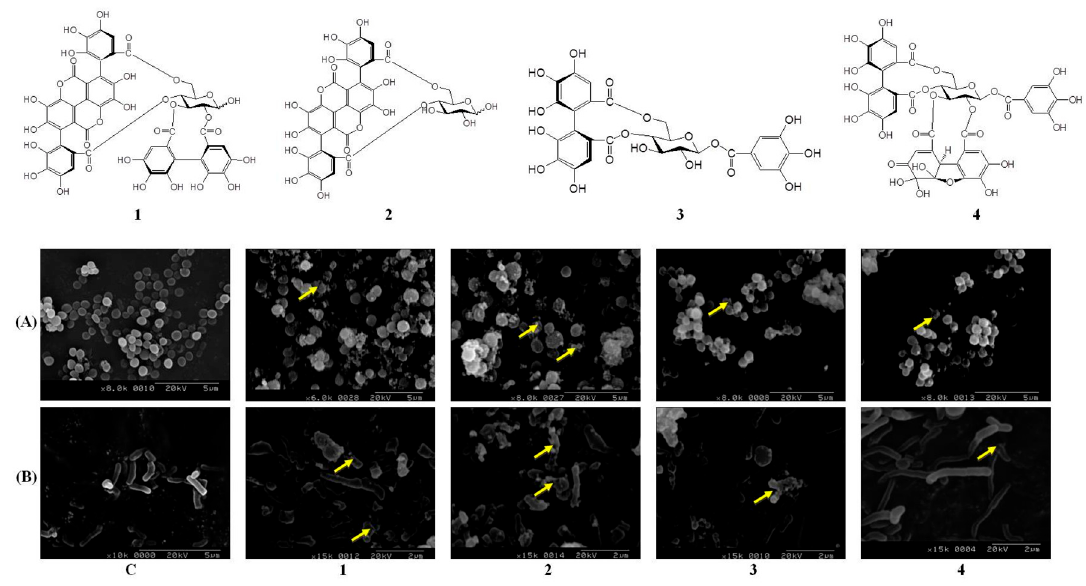
Figure 2. Shrinkage and damage of S . aureus ( A ) and P . acnes ( B ) after treatment with four hydrolysable tannins isolated from pomegranate extract (PG-E): punicalagin ( 1 ), punicalin ( 2 ), strictinin A ( 3 ), and granatin B ( 4 ); All photos were taken with scanning electron microscopy; C: control group; The concentration of 1 to 4 was 100 µg/mL; Data are from three separate experiments, the picture of one of which is shown; The arrow indicates a disruption site of bacteria; Scale bar of control group is 5 µm; Scale bar of four hydrolysable tannins against S . aureus and P . acnes is 5 µm and 2 µm, respectively.